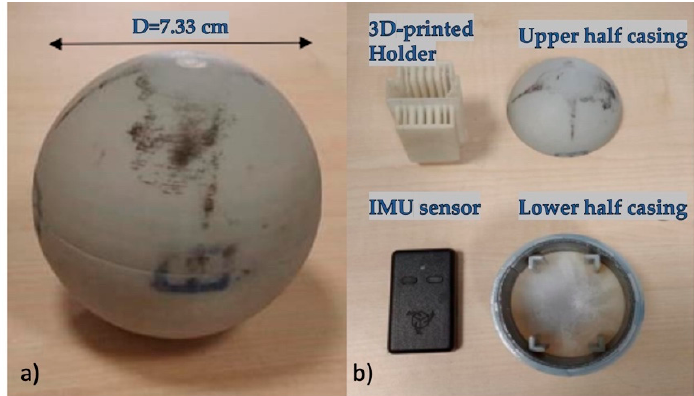
Figure 6. ( a ) The instrumented particle shell. ( b ) The instrumented particle with its internal compo- nents: inner casing, outer casing, sensor, O-ring, holder for sensor and density